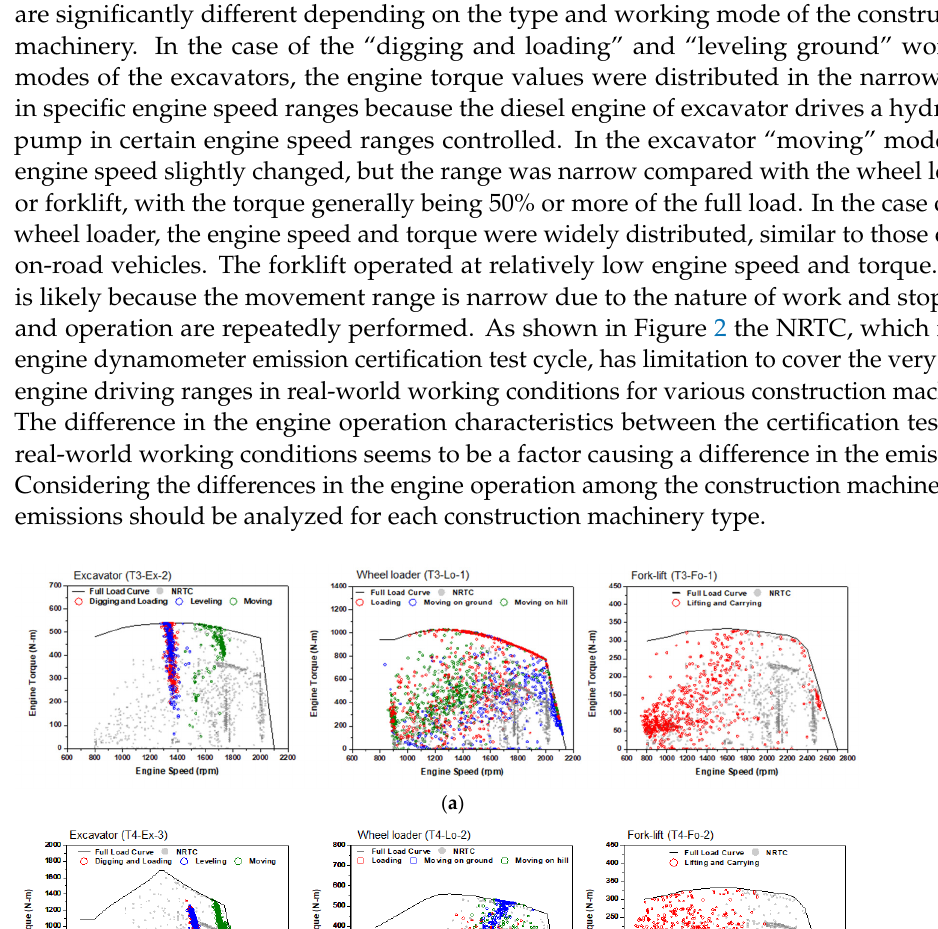
Figure 3. Schematic diagram for the emission with concern of the work with 1 kWh based moving average window (MAW) method.